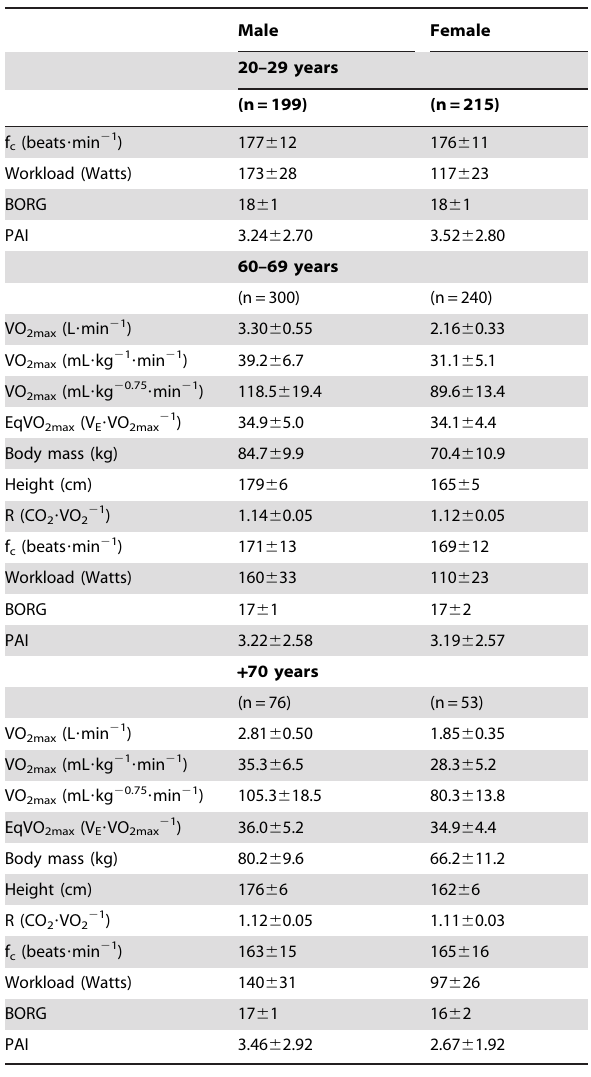
Table 2. Physiological variables in the HUNT 3 Fitness study stratified by sex and age groups.